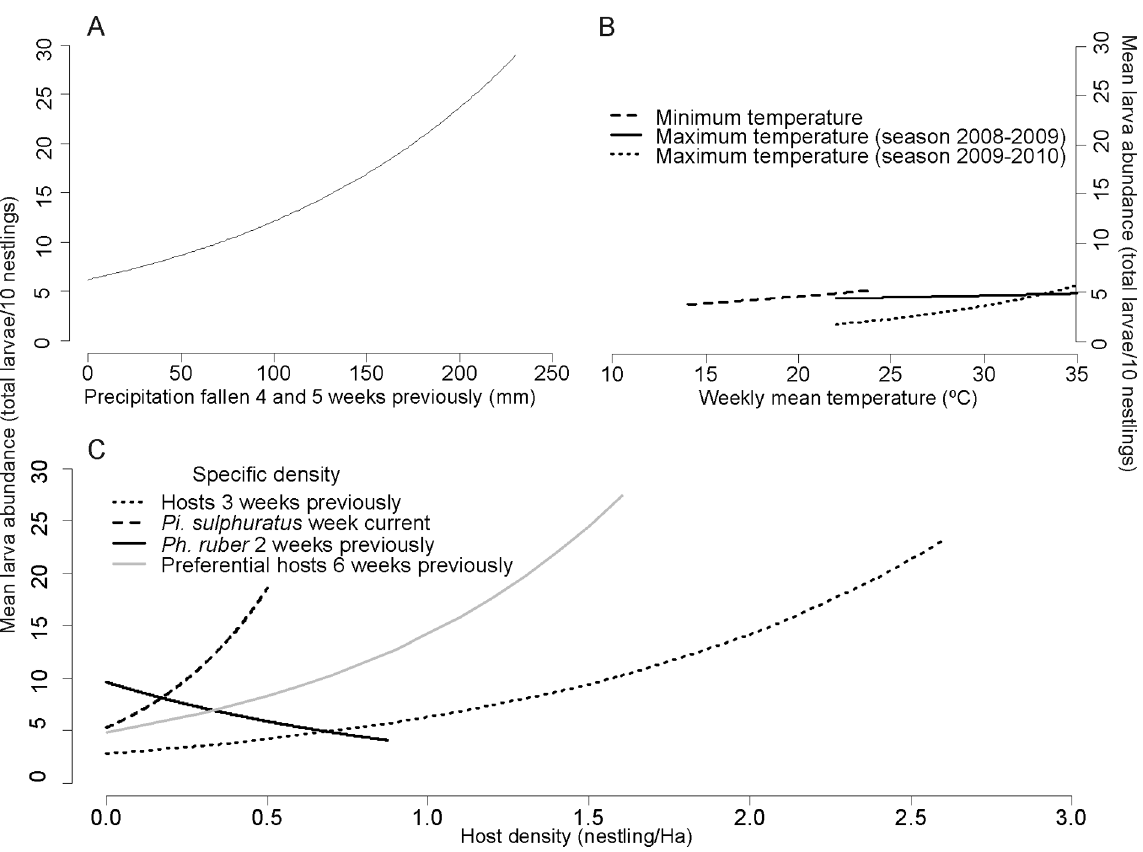
Figure 3. Mean Philornis abundance as predicted by the best community-level models. A) Effect of precipitation (mm) fallen 4 and 5 weeks previously. B) Effect of weekly mean temperature. C) Effect of host density.